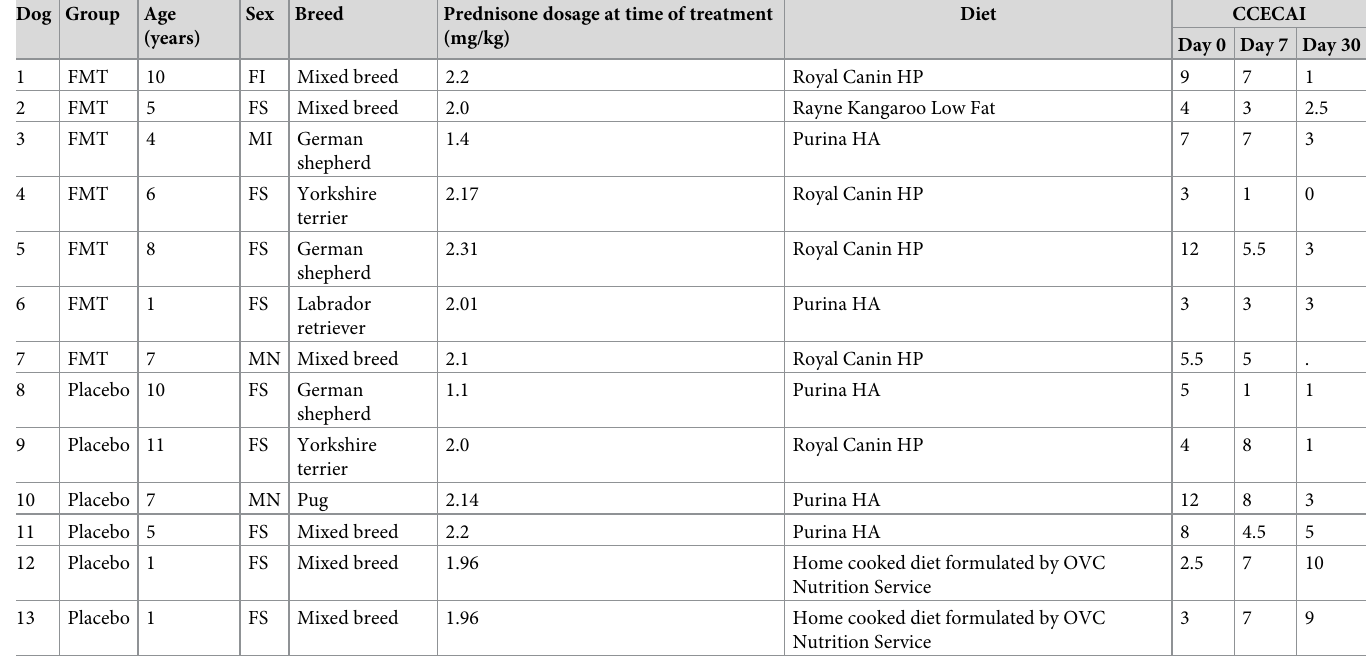
Table 2. Characteristics of included